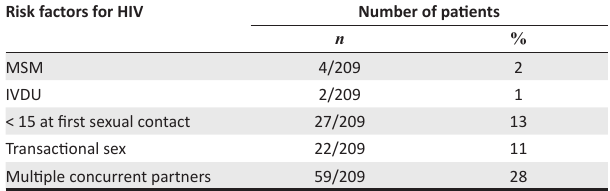
TABLE 7: Risk factors for Human Immunodeficiency